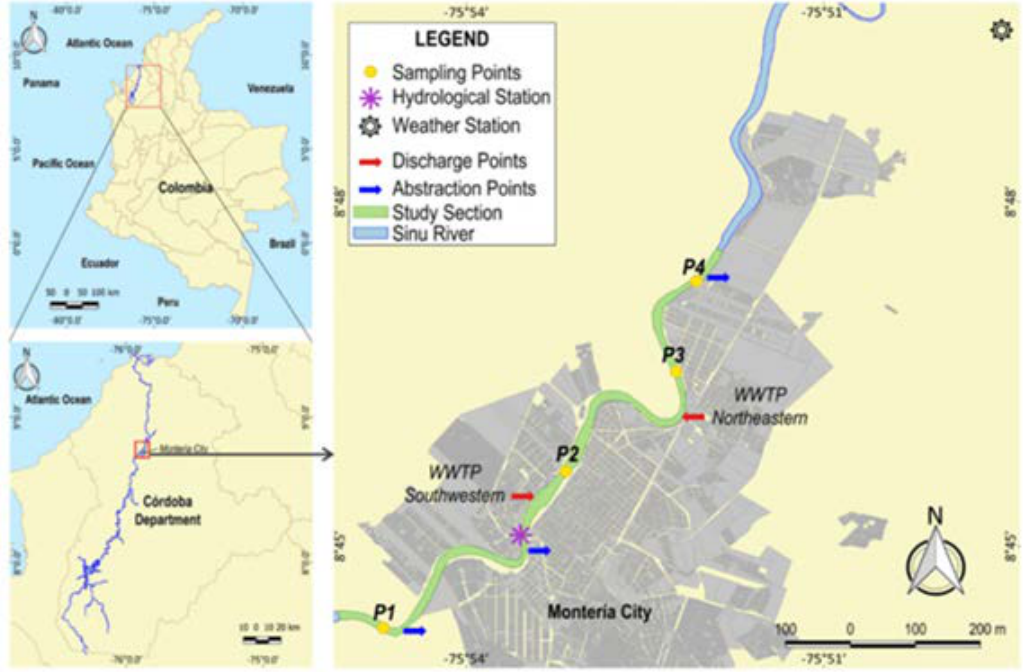
Fig. 1: Geographic location of the study area and sampling locations in the Sinú River section through Monteria city, Colombia